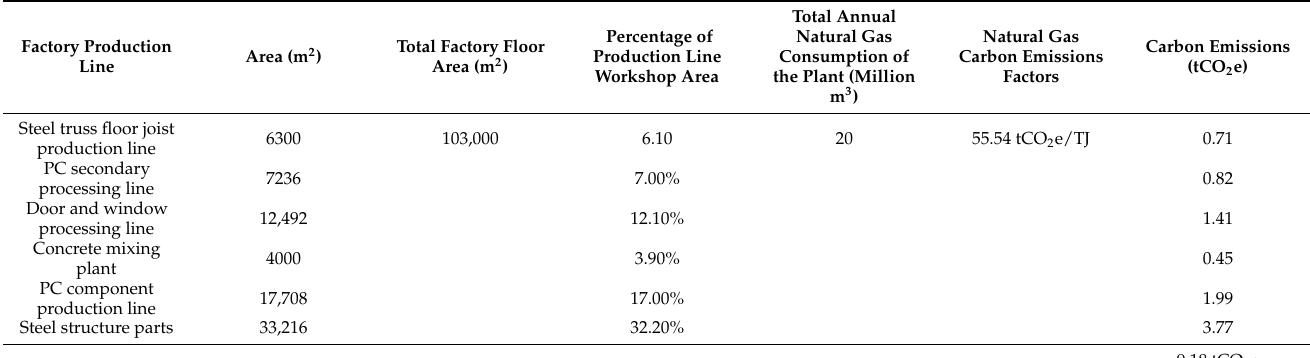
Table 12. Carbon emission of N p i